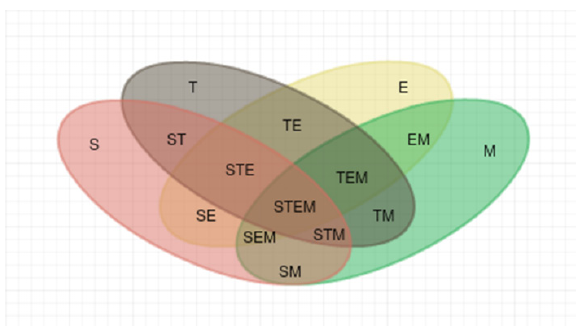
Fig. 1. STEM is interdisciplinary, occurring at the intersection of 2 or more of the STEM